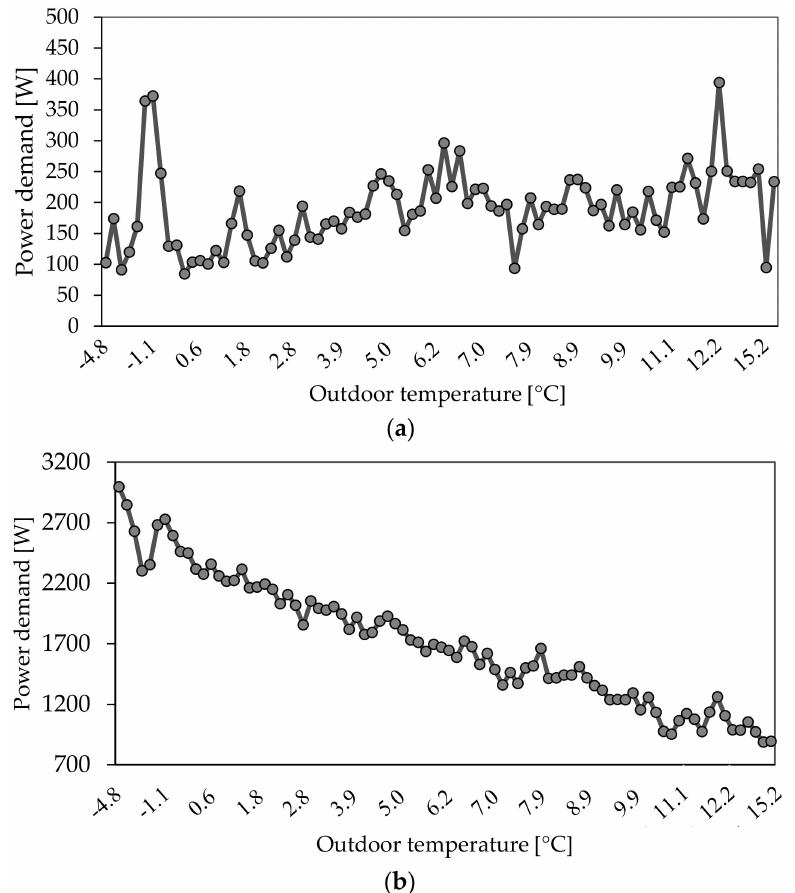
Figure 11. Relationship between electricity demand, and the difference between the outside and inside temperatures of the house. ( a ) Without any electric heater. ( b ) With several electric